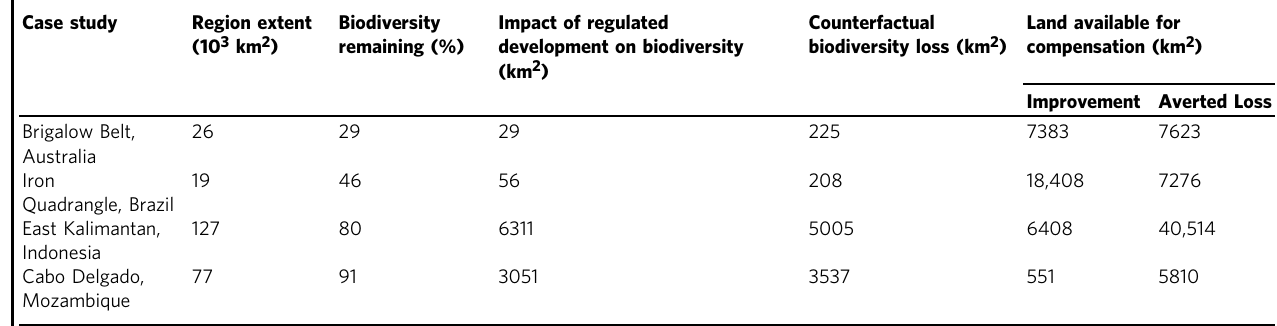
Biodiversityremainingindicatesthecurrentextentofnaturalvegetationrelativetoitspre-clearingextent.Regulateddevelopmentvariesacrosscases(Fig.1)anditsimpactonbiodiversityrepresentsthe extent of vegetation cleared by these developments during the simulation time period for each case study. Counterfactual biodiversity losses indicate unregulated vegetation clearing during the simulation time period. Land availablefor each compensation approach is de fi ned as either the extent of clear land availablefor Improvement, or unprotected vegetation availablefor Averted Loss. Refer to Supplementary Methods 1 – 4 for more